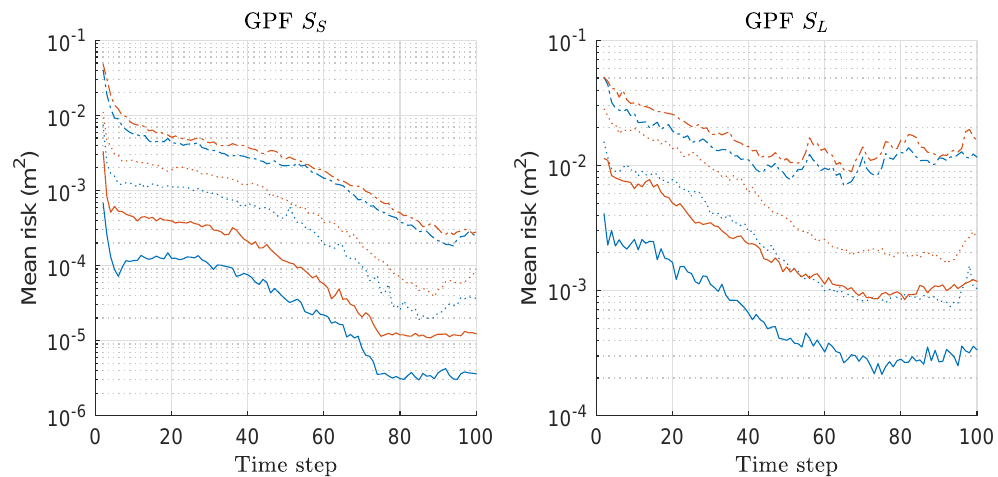
Figure 14. Mean-risk over 300 runs with 1000 particles based on Equation (20) for GPF and MGPF. Results regarding only r x are shown, and those regarding r y showed similar results. Legend: line style (dash-dot: M = 2; dotted: M = 5; solid: M = 10); (line color: blue: GPF; red: MGPF).